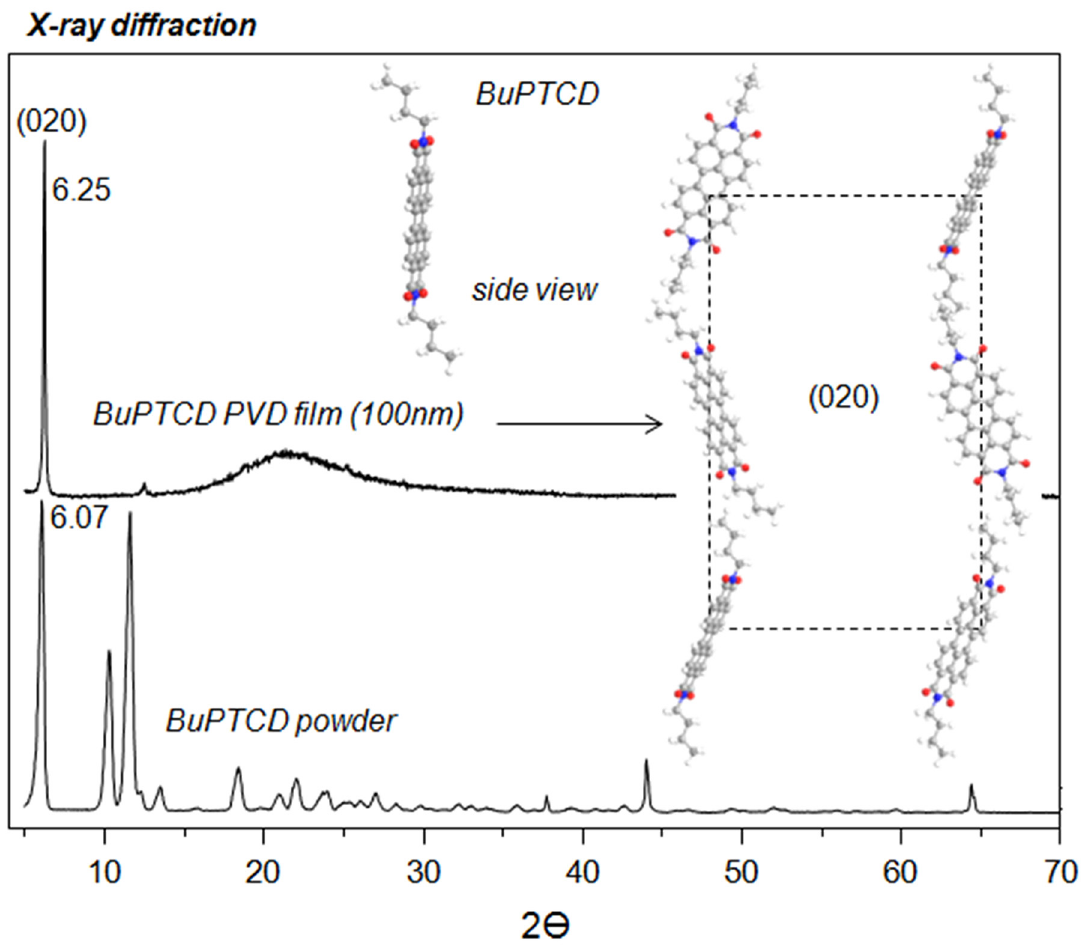
Figure 7. X-ray diffractograms for BuPTCD powder and 100 nm PVD film. The inset depicts the BuPTCD preferential organization in PVD